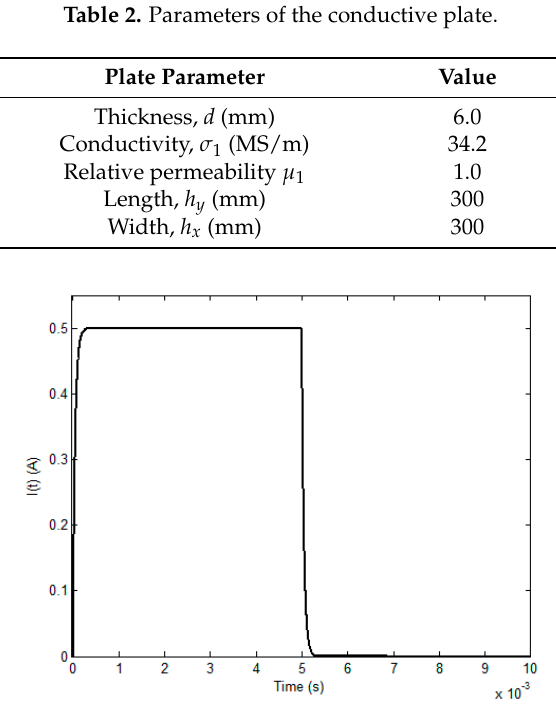
Figure 3. The excitation current I ( t ).